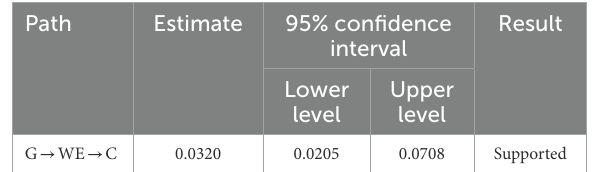
TABLE 6 Mediation